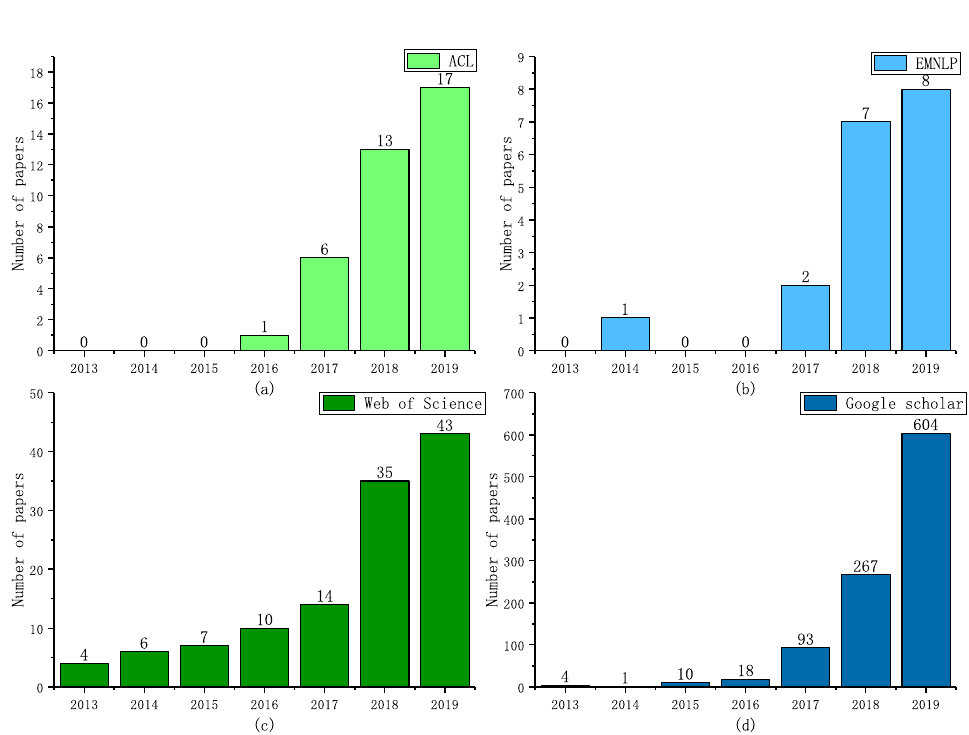
Figure 2. The number of research papers for machine reading comprehension each year: ( a ) The number of research papers on machine reading comprehension (MRC) in ACL from 2013 to 2019. ( b ) The number of research papers on MRC in ENMLP from 2013 to 2019. ( c ) The number of research papers on MRC in Web of Science from 2013 to 2019. ( d ) The number of research papers on MRC in Google scholar from 2013 to